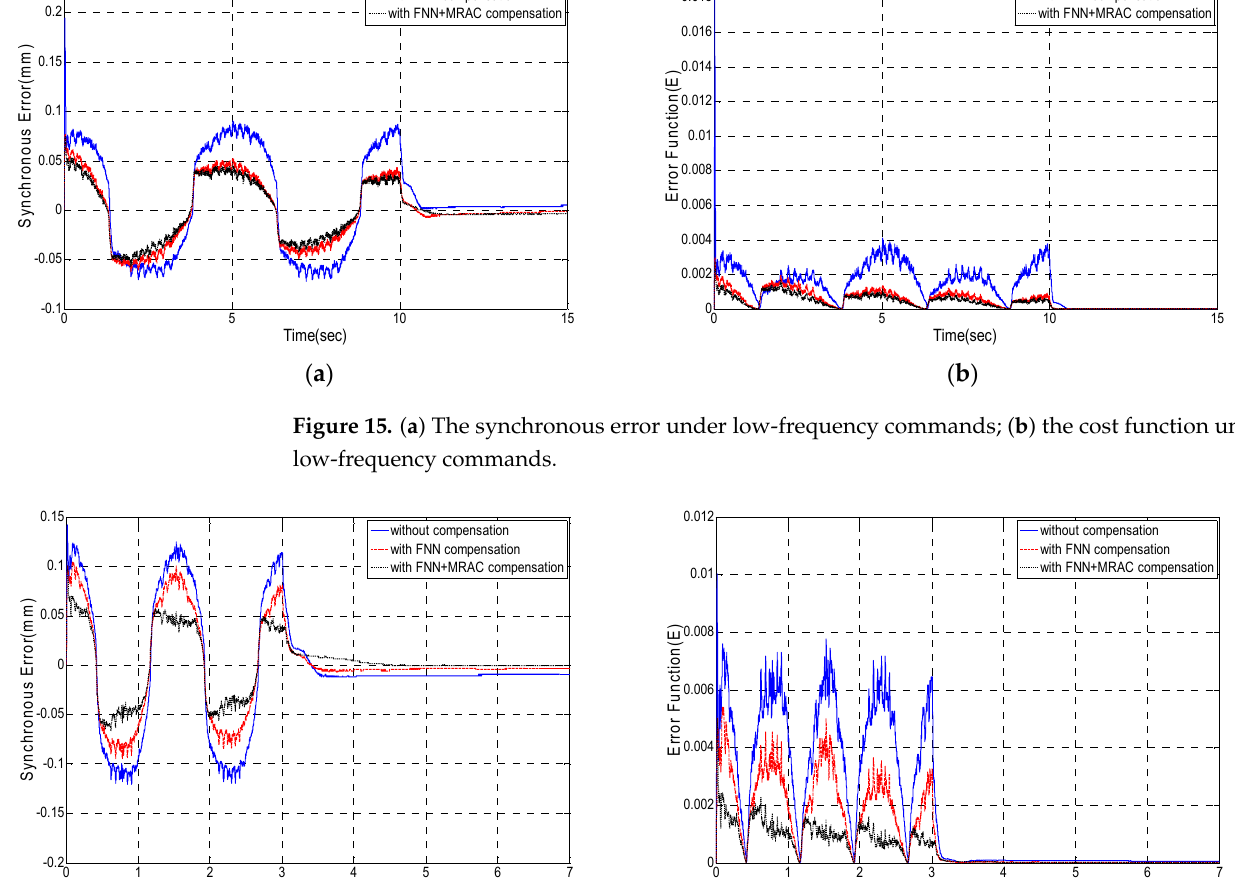
( b ) Figure 17. ( a ) The synchronous error under low-frequency commands with disturbances; ( b ) the synchronous error under high-frequency commands with disturbances. Table 4. Synchronous performance under high-frequency commands.